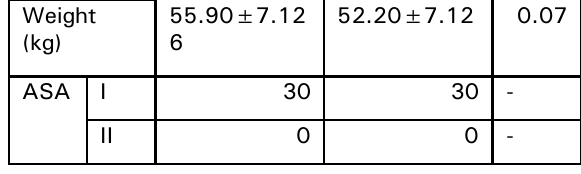
Table 2: Comparison of stone sizes & Locations: